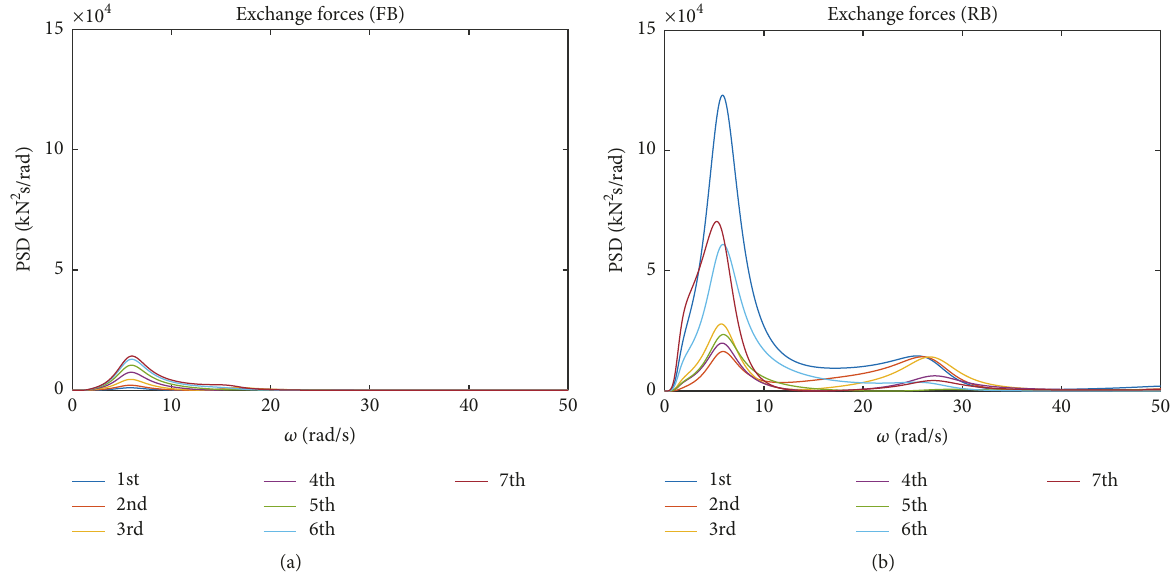
Figure 8: PSD of the exchange forces for the FB (a) and RB (b) configurations.